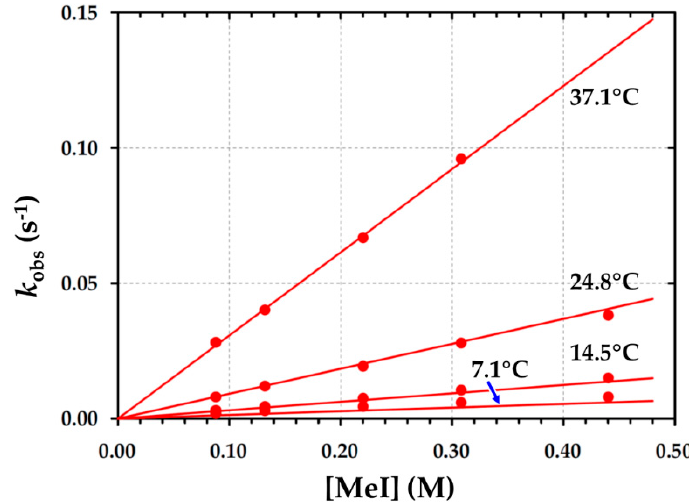
Figure 9. Temperature and [MeI] dependence of the pseudo first-order rate constant for the formation of Rh III -alkyl in [Rh 1 (Indol’)(CO)(PPh 3 )Rh 2 (CO)(PPh 3 ) 2 ] ( B2 ) via time-resolved UV/vis spectroscopy in dichloromethane; ( λ = 450 nm) and [ B2 ] = 8.35 × 10 − 4 M.